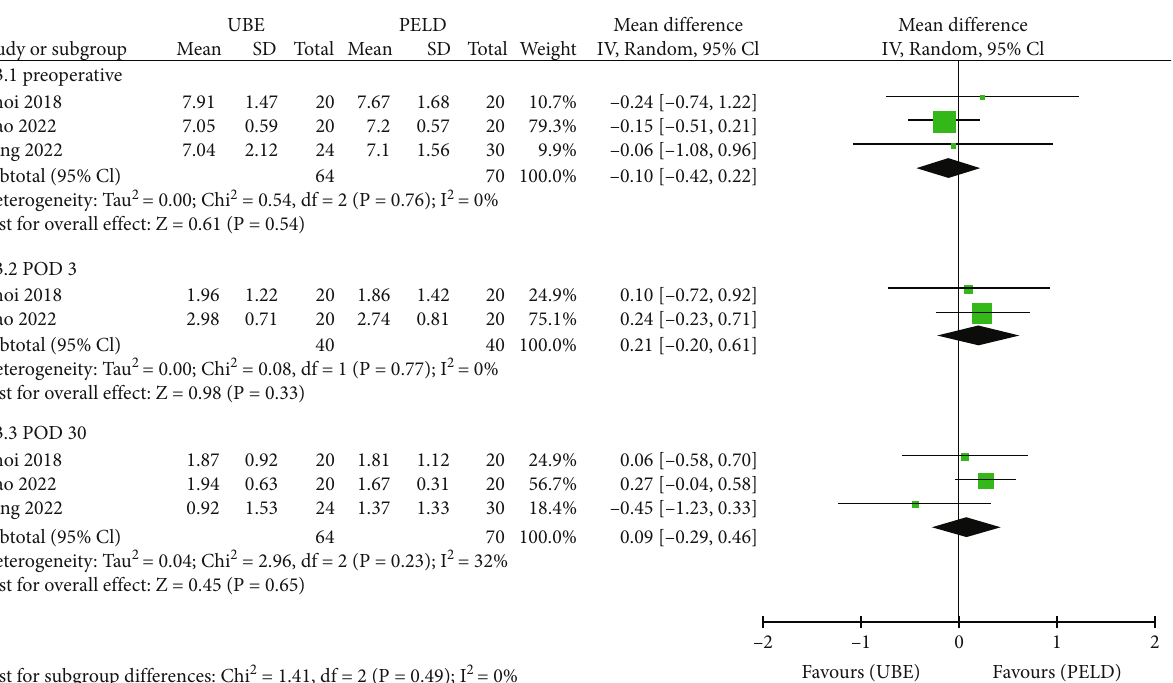
Figure 5: Forest plots for VAS of leg pain at preoperative/postoperative 3 days/postoperative 30